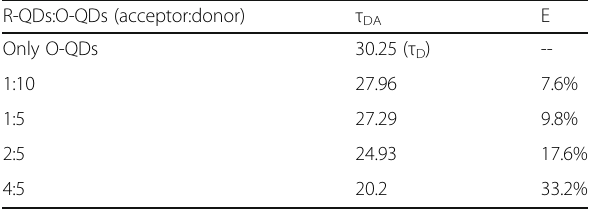
Table 1 FRET efficiency of composite-QD silicone thin films with different ratios of acceptor to